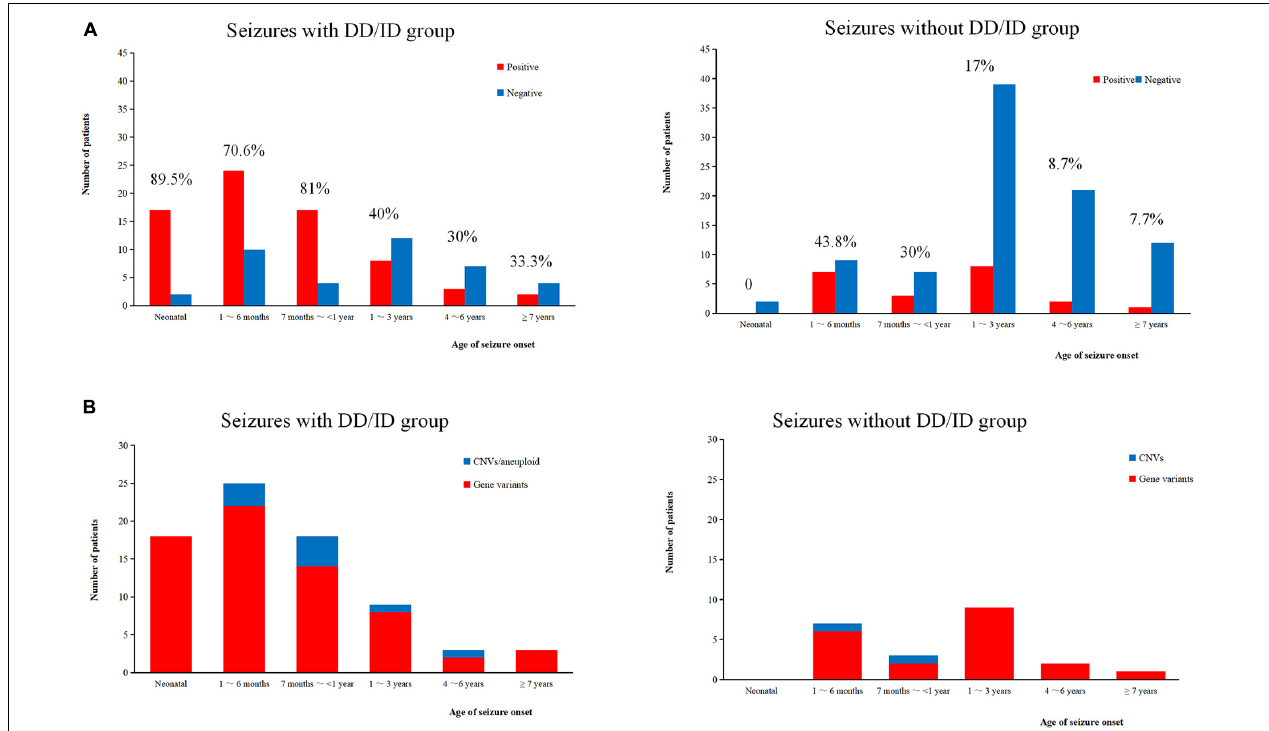
FIGURE 2 | Molecular diagnosis yield in different ages. (A) The molecular diagnosis yield in the groups of epilepsy with DD/ID and without DD/ID during different ages of seizure onset. (B) The individuals containing gene variants in the groups of epilepsy with DD/ID and without DD/ID during different ages of seizure onset. The percentage in the diagram represents the diagnosis positive rate = (P + LP)/all individuals in this